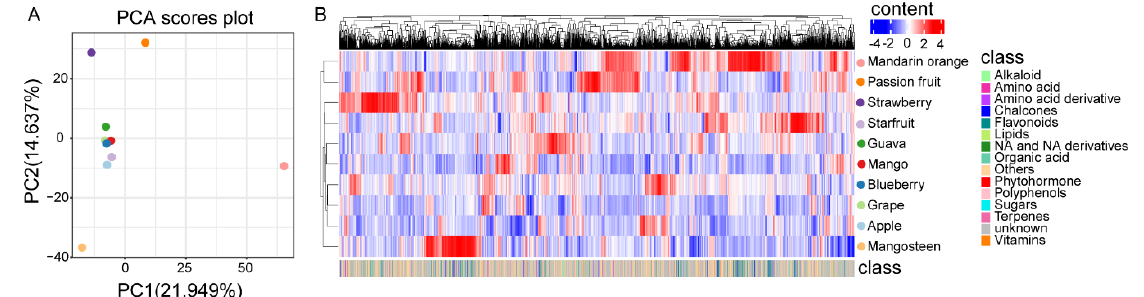
Figure 4. Metabolic variation of the ten kinds of fruits. ( A ) Principal component analysis (PCA) of the metabolite profiling of ten fruits. The mean value of three biological replications was used for PCA. ( B ) Heat map based on metabolome data of ten kinds of fruits. The mean value of three biological replications was used for metabolite profiling. The content value of each metabolite was normalized, and hierarchical clustering was performed. The red color indicates a high abundance of a metabolite, whereas the blue color represents a low relative abundance of a metabolite. Each fruit species is visualized in a single row, and each metabolite is represented by a single column. The bottom annotation with different colors represents the class to which the corresponding metabolite belongs.